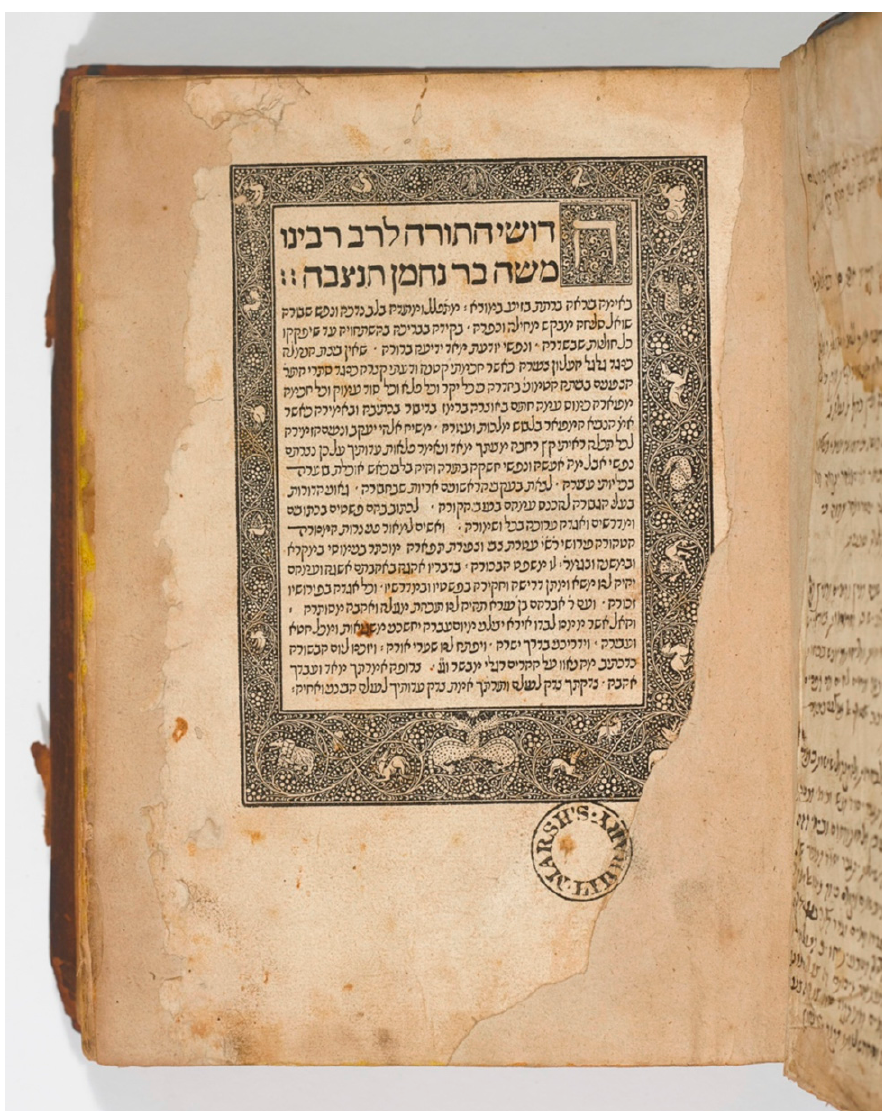
Figure 10. Commentary on the Torah, by Moses ben Nachman; Marsh’s Library C.3.1.26.